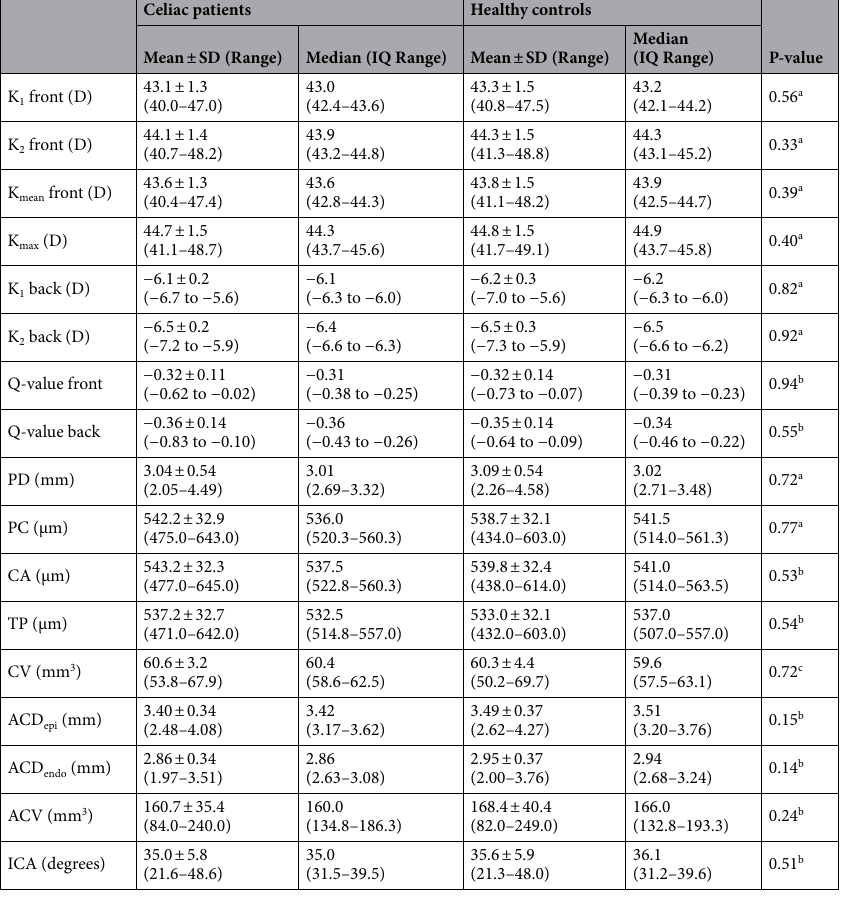
Table 4. Tomographic parameters assessed with Pentacam HR in the two study groups. a Mann Whitney